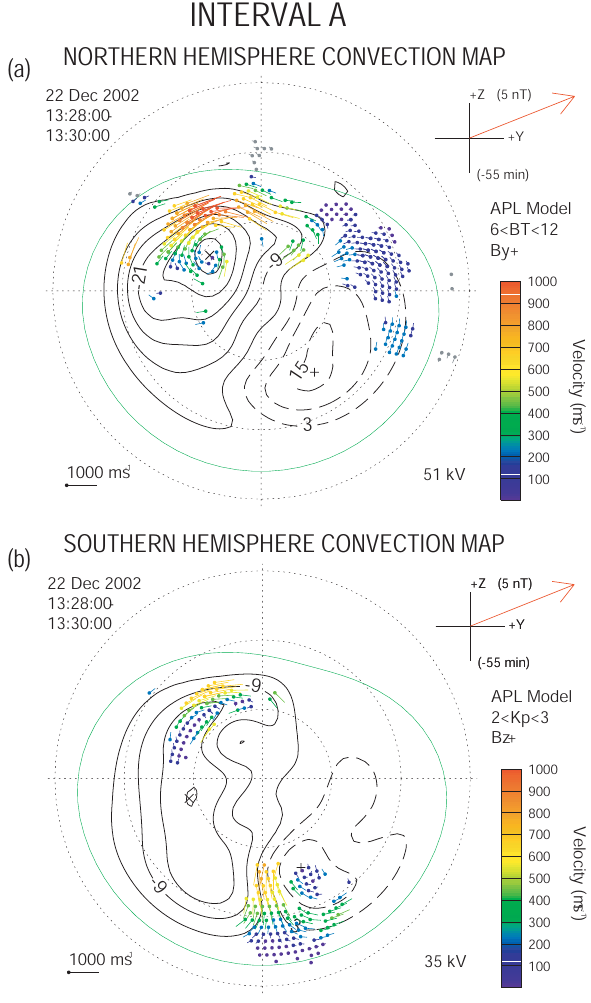
Fig. 6. (a) Shows map-potential flow vectors and equipotential streamlines observed by the Northern Hemisphere radars during the interval 13:28 to 13:30 UT. The vectors are presented as a func- tion of magnetic local time and magnetic latitude, with noon at the top and dusk to the left. The velocity of the fitted vectors is coded both in colour (blue indicating the slowest velocities, red the fastest) and in the length of the vectors. The red arrow in the top left-hand corner shows the IMF clock angle at 13:28 UT. (b) Shows map- potential flow vectors and equipotential flow streamlines observed by the Southern Hemisphere radars in the same interval, in the same format. Noon is again at the top of the plot, and dusk to the left.